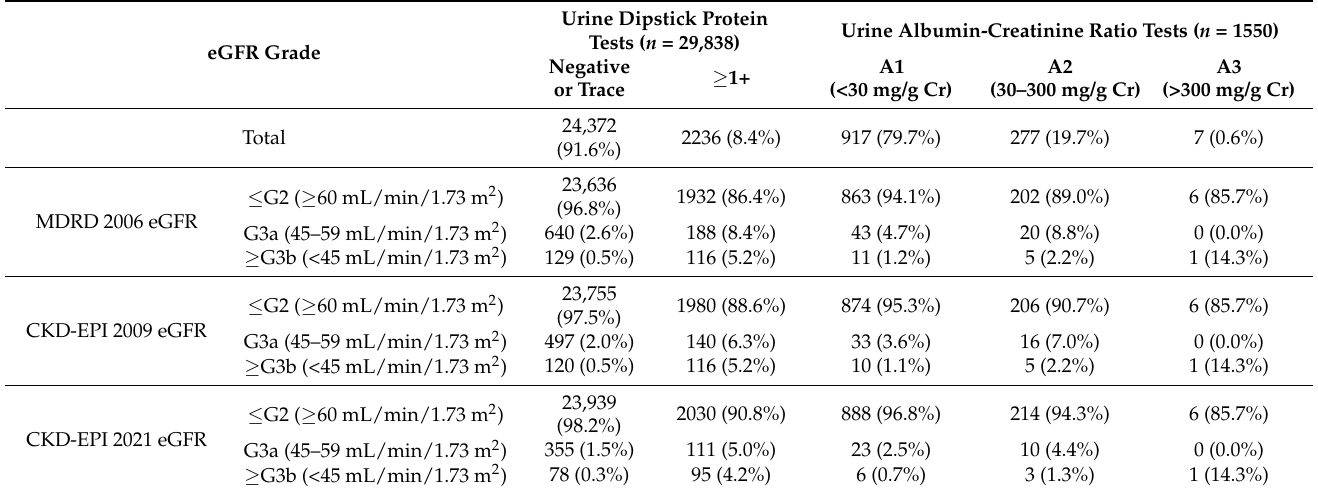
Table 3. Overall agreement between dipstick proteinuria (equal or greater than 1+), urine albumin- creatinine ratio, and grade of estimated glomerular filtration rates (eGFR).